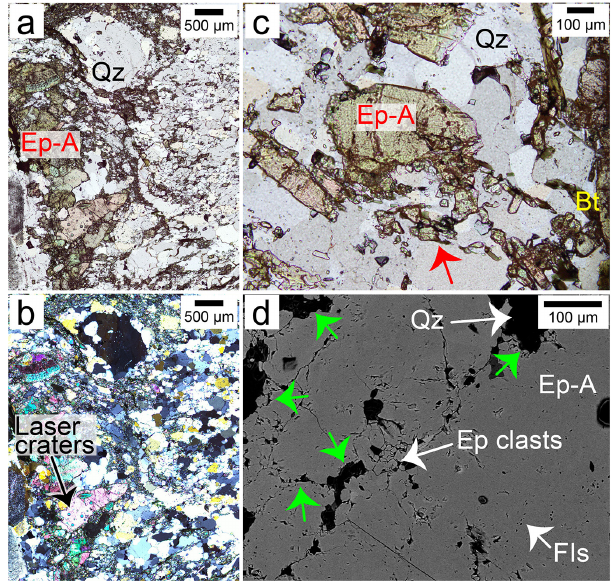
Figure 5. Details of epidote in layer 1. (a–b) Transmitted-light mi- crophotographs of epidote and quartz in plane-polarized (a) and cross-polarized (b) light. (c) One isolated epidote grain surrounded by epidote clasts (red arrow). (d) Backscattered electron image of one epidote grain showing lobate grain boundaries and microp- orosity suggested by the presence of fluid inclusions (FIs). Bt: bi- otite; Ep: epidote; Ep-A: Epidote-A; Qz: quartz. Anomalous bire- fringence in panels (a) and (c) is due to the thickness of the thin section (ca.